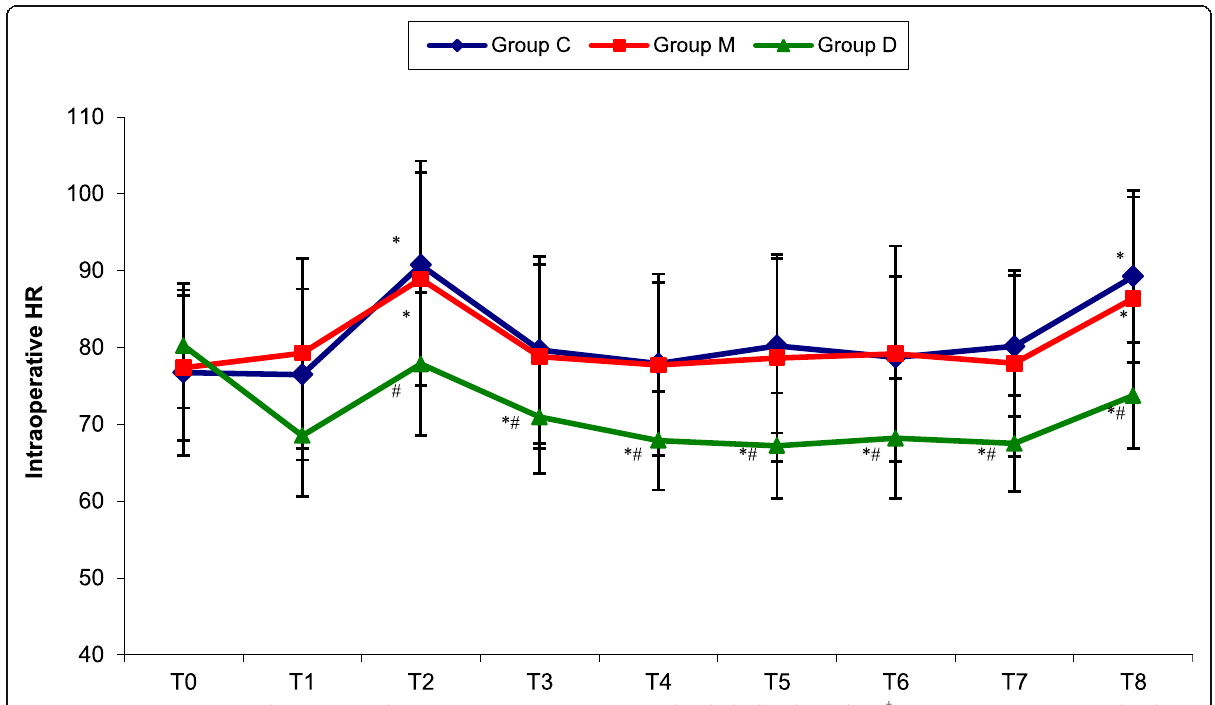
Fig. 3 Intraoperative HR recordings expressed as mean ± SD. * P < 0.05 (compared with the baseline value), † P < 0.05 (group M compared with group C), ‡ P < 0.05 (group D compared with group C), # P value < 0.05 (group D compared with group M)